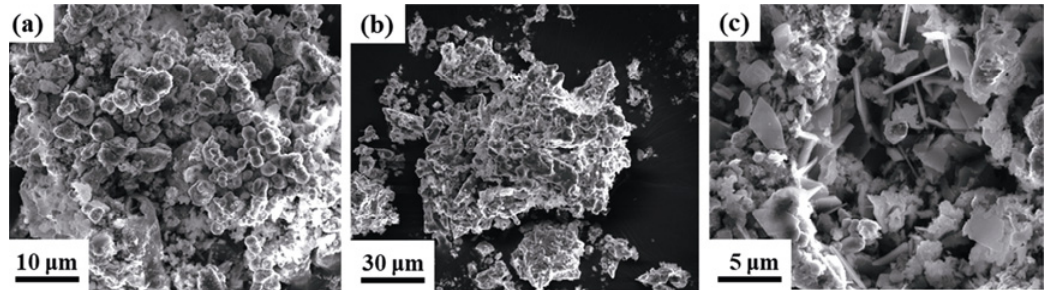
Fig. 6 Morphology of the samples synthesized from 1Mo/1.3Al/B by SHS for (a) coarse raw powders, (b) fine raw powders, and (c) ultra-fine raw